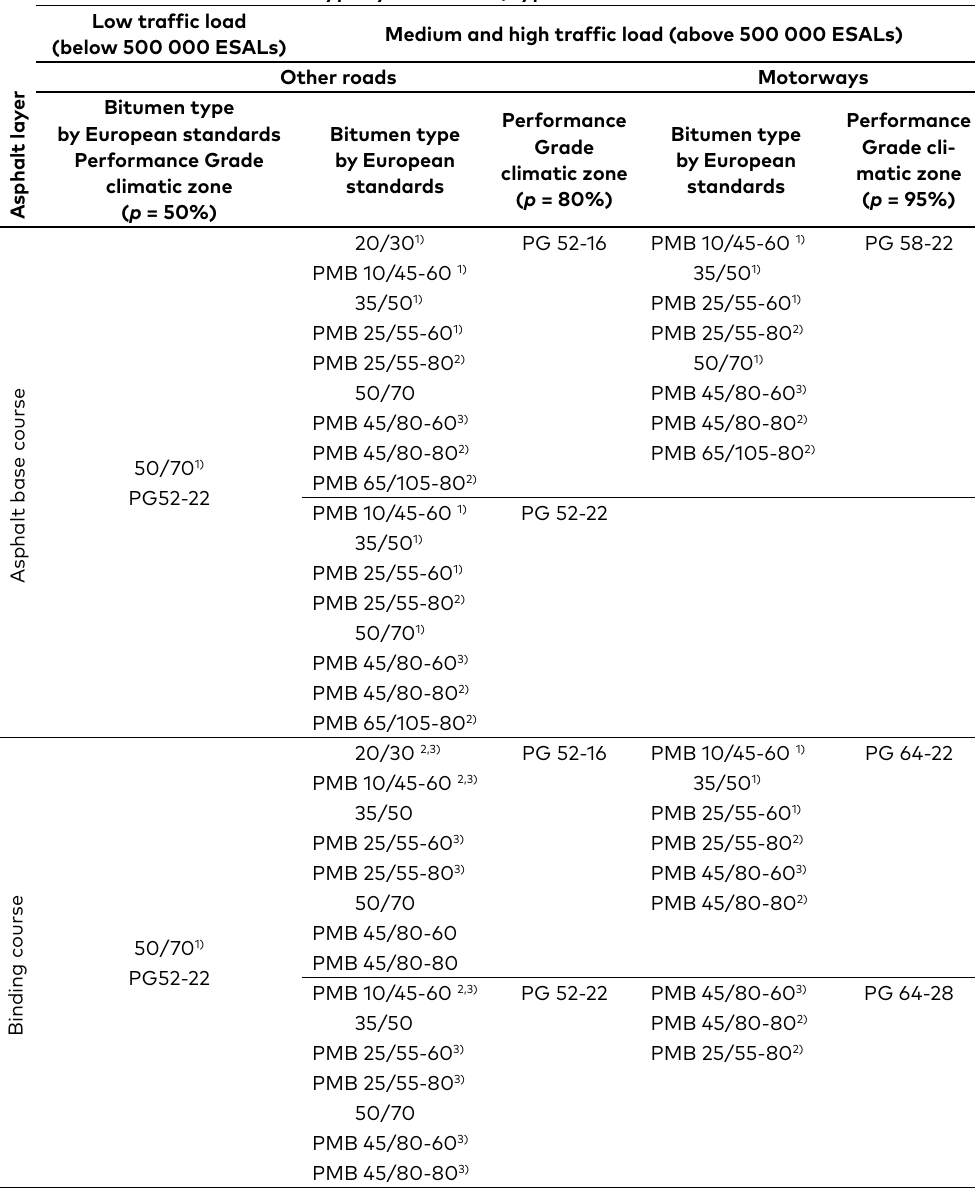
Table 4. Proposal of bitumens assignment regarding performance properties and climatic